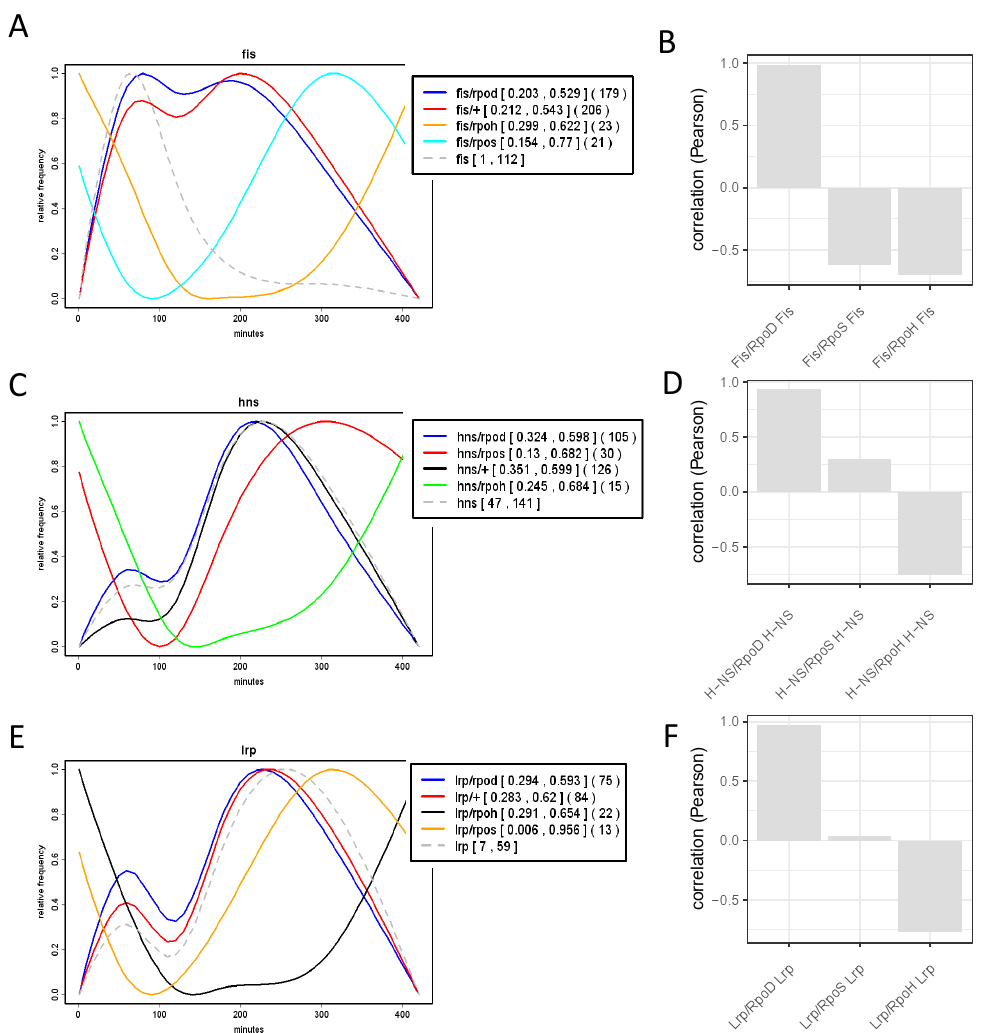
Figure 6. Correlation between the temporal expression of NAP regulons and couplons. ( A ). Growth phase-dependent expression of the FIS regulon, FIS/RpoD and FIS/ASF couplons. The colored curves were computed as average patterns of all the regulon/couplon genes and normalized to 1.0 (for details see legend to Supplementary Figure S6). Abscissa—time in minutes after inoculation of cells in fresh growth medium; ordinate—relative frequency of each class of genes as indicated in the inset. ( B ). Pearson correlations (ordinate) between the temporal expression of FIS regulon, FIS/RpoD couplons and FIS/ASF couplons (FIS/RpoS and FIS/RpoH, as indicated on abscissa). ( C , D ). The same as in ( A , B ), but for H-NS regulon and couplons. ( E , F ), the same as in ( A , B ) but for Lrp regulon and couplons. Note the high positive correlation between the temporal expression of NAP regulons and NAP/RpoD couplons but not the NAP/ASF couplons. Plots A , C and E , data from [29]. The expression patterns of fis , hns and lrp genes (in A , C and E respectively) are indicated by grey dashed lines. fis/+, hns/+ and lrp/+ respectively indicate the FIS, H-NS and Lrp regulons. Numbers in squared brackets indicate the minimum and maximum of the regulon/couplon before normalization to [0;1]. Note, that these numbers are averages of the regulon/couplon genes already normaized individually to [0;1]. Numbers in round brackets indicate the number of genes involved in the respective regulon or couplon. The Escherichia coli CSH50 overnight (16 h) cultures were inoculated at an initial OD600 of 0.1 in rich double yeast-tryptone (dYT) medium and grown in a fermenter under constant pH 7.4 and high aeration (5 L air per min) at 37 ◦ C for 7 h. Samples for RNA-seq were taken at 1, 2, 3, 5 and 7 h after inoculation and immediately dissolved in ice-cold ethanol–phenol (5% phenol) solution to prevent mRNA degradation. RNA was extracted using the RNeasy Mini kit (Qiagen, Hilden Germany) and treated with Turbo DNase (Life Technologies, Carlsbad USA). Subsequent rRNA depletion was carried out using the MicrobExpress kit (Life Technologies) and 0.5 µ g of enriched mRNA of each sample were subjected to RNA-seq (Illumina HiSeq